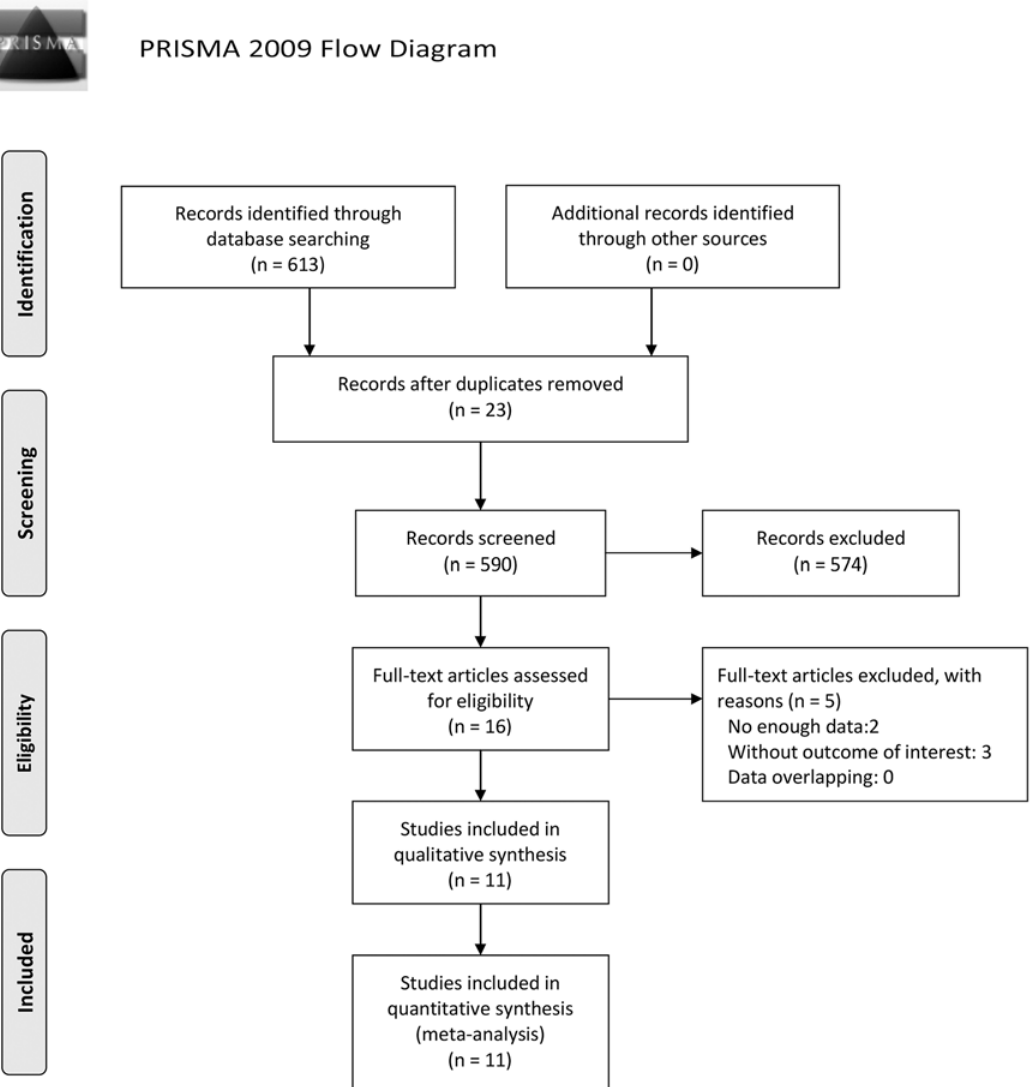
Fig 1. Flow Diagram of Literature Search. Of 613 potentially relevant citations, 11 articles met our inclusion criteria and were included in the meta-analysis. From : Moher D, Liberati A, Tetzlaff J, Altman DG, The PRISMA Group (2009). P referred R eporting I tems for S ystematic Reviews and M eta- A nalyses: